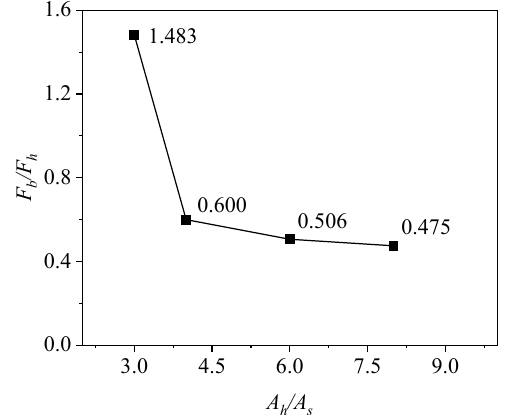
Figure 22. Relationship between F b / F h and head size.